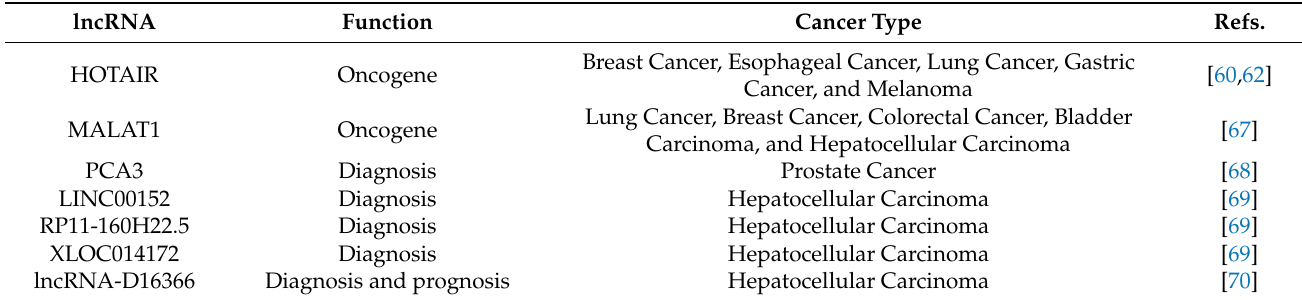
Table 4. LncRNAs as clinical biomarkers.